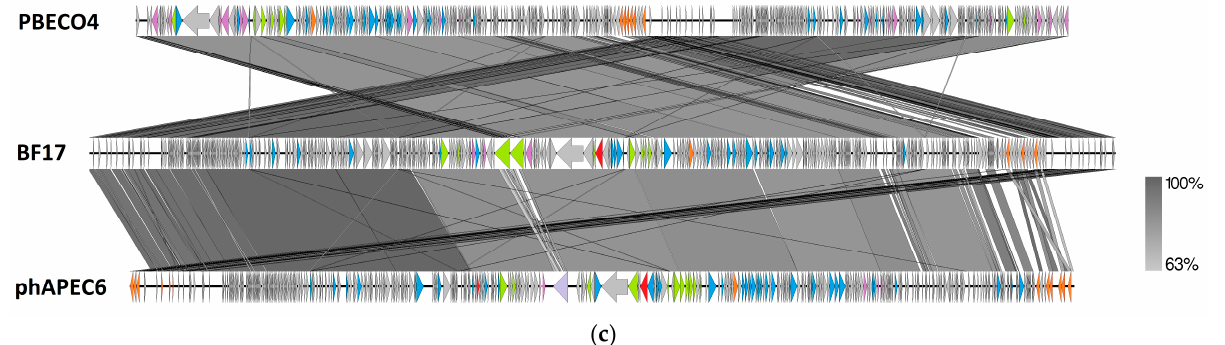
Figure 4. Genomic and phylogenetic analysis of bacteriophage BF17. ( a ) Phylogenetic tree of BF17 (in bold) generated by VICTOR using the whole-genome sequences of phage homologs in BLASTn. The numbers above branches are GBDP pseudo-bootstrap support values from 100 replications. ( b ) VIRIDIC heatmap based on intergenomic similarities between BF17 and closest homologs in BLASTn. The number in the chart represents the similarity percentage. ( c ) Genome comparison of BF17 with closely related members of the Asteriusvirus genus. The grey shading indicates sequence similarities between the genomes. The predicted functions of proteins are indicated by different colors: phage morphogenesis and virion structure (green arrows), DNA packaging (orange arrows), host lysis (red arrows), phage DNA replication and modification (blue arrows), and additional functions (purple arrows). Grey arrows represent ORFs of unknown functions.